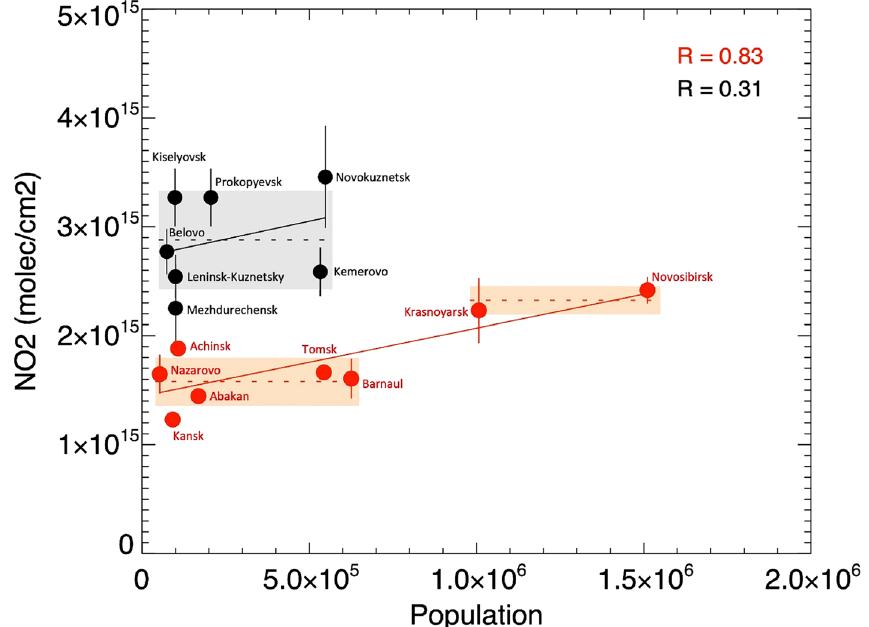
Figure 5. Scatter plot of mean OMI NO 2 and population for the main cities in the Kuzbass basin (black circles) and surrounding Siberian cities (red circles) for the same time period as Fig. 4. The dot labeled ‘Kemerovo’ indicates Kemerovo city. Shaded regions highlight the standard deviation and the mean (horizontal dashed lines) of the population of the cities larger than about 1,000,000 inhabitants and lower than about 500,000